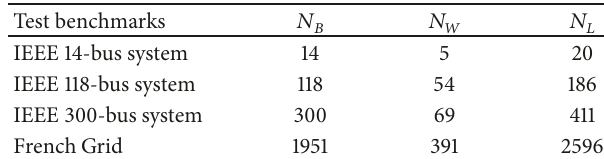
Table 1: Description of test benchmarks.